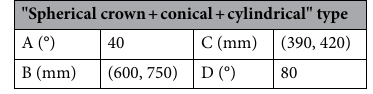
Table 6. Basic parameter setting.